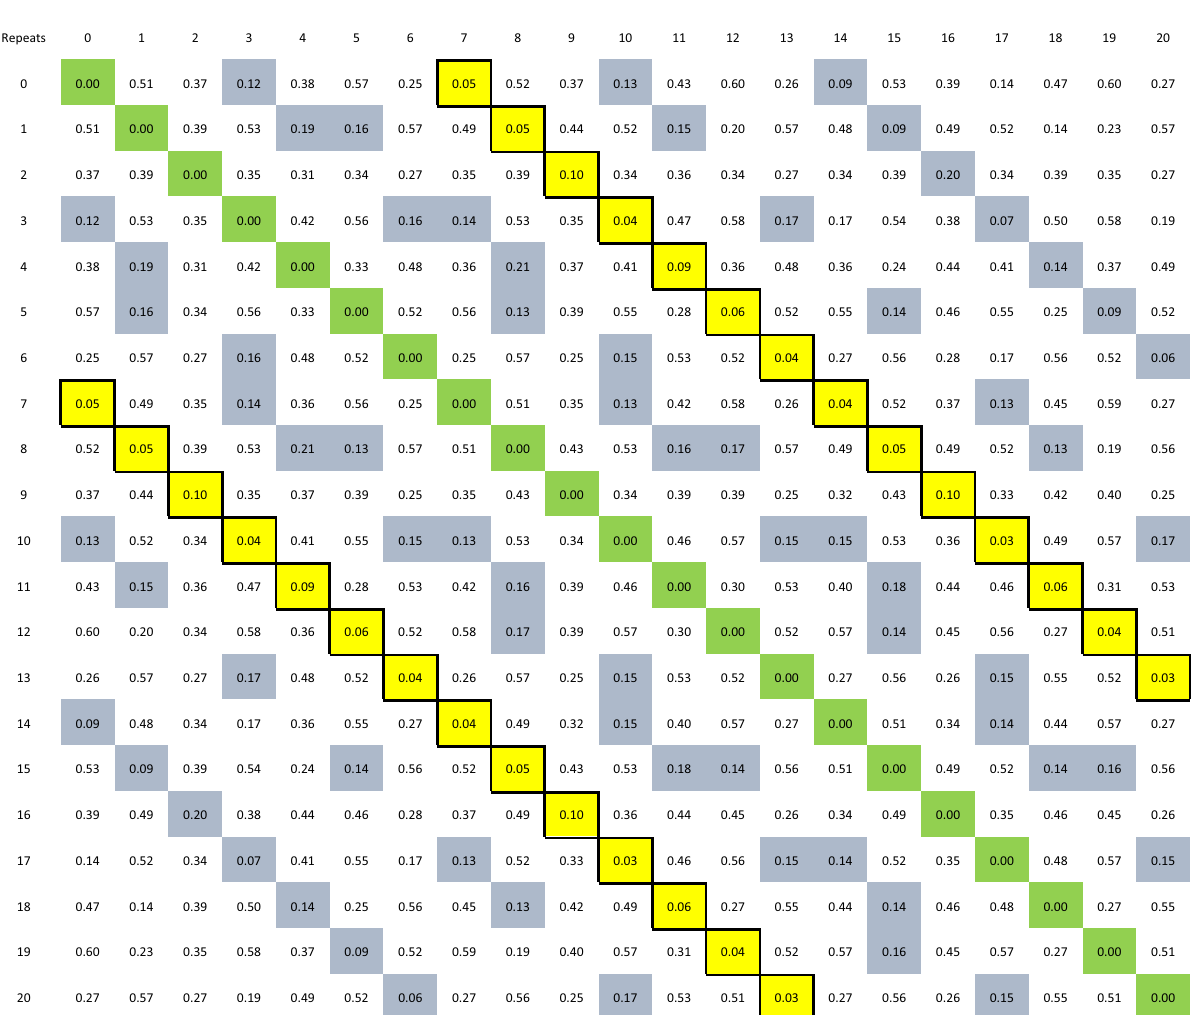
Table 2. Divergence scores of existing (7 and 8-repeat) and hypothetical PRKACB repeat periodicals in human. The highlighted areas represent the 30 percentile of the entire scores (the lowest 30% of the entire scores). The 7-repeatperiodical (solid yellow cells) revealed continuous and strictly narrow divergence score variation in comparison to the8-repeat and all other periodicals. Only the 7 and 8 repeats were detected in the human population